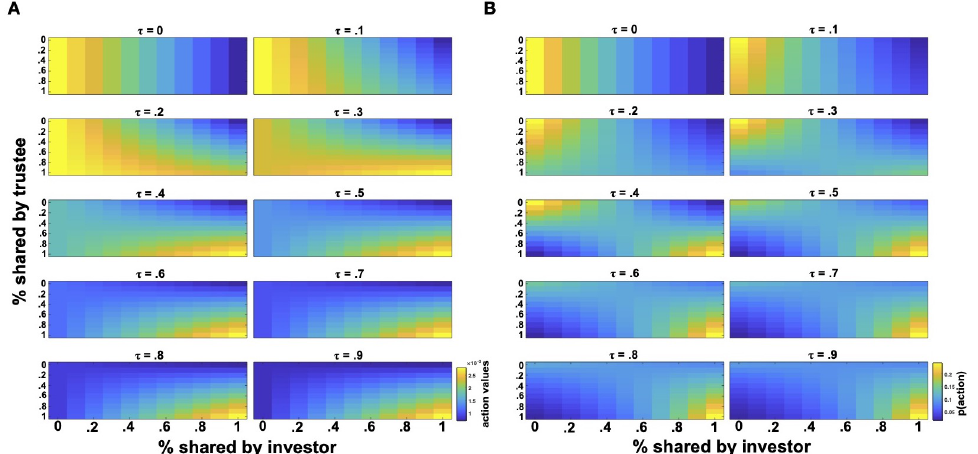
Figure 4. Action values and probabilities with varying τ . Action values ( A ) and action probabilities ( B ) for investors with different τ parameters (i.e., propensity to trust or accept vulnerability) as computed according to the vulnerability model. For action probability estimation, the χ parameter of investors’ policy is set to